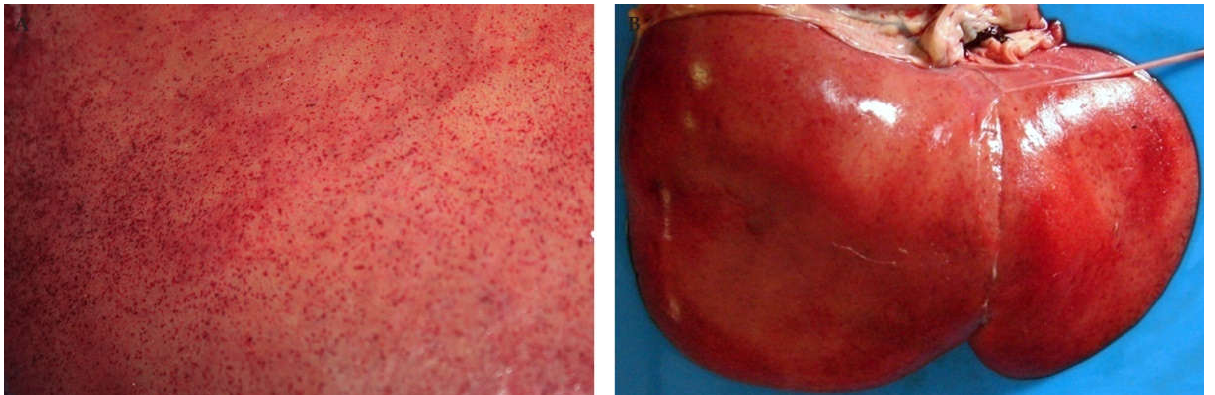
Figure 1. Macroscopic pathology of the liver in sheep naturally infected with RVFV. ( A ) Innumerable petechia on the parietal surface of the liver of an adult sheep. ( B ) Liver of a new-born lamb with extensive necrosis and pinpoint subcapsular petechia giving the liver a pale yellow to red mottled appearance.